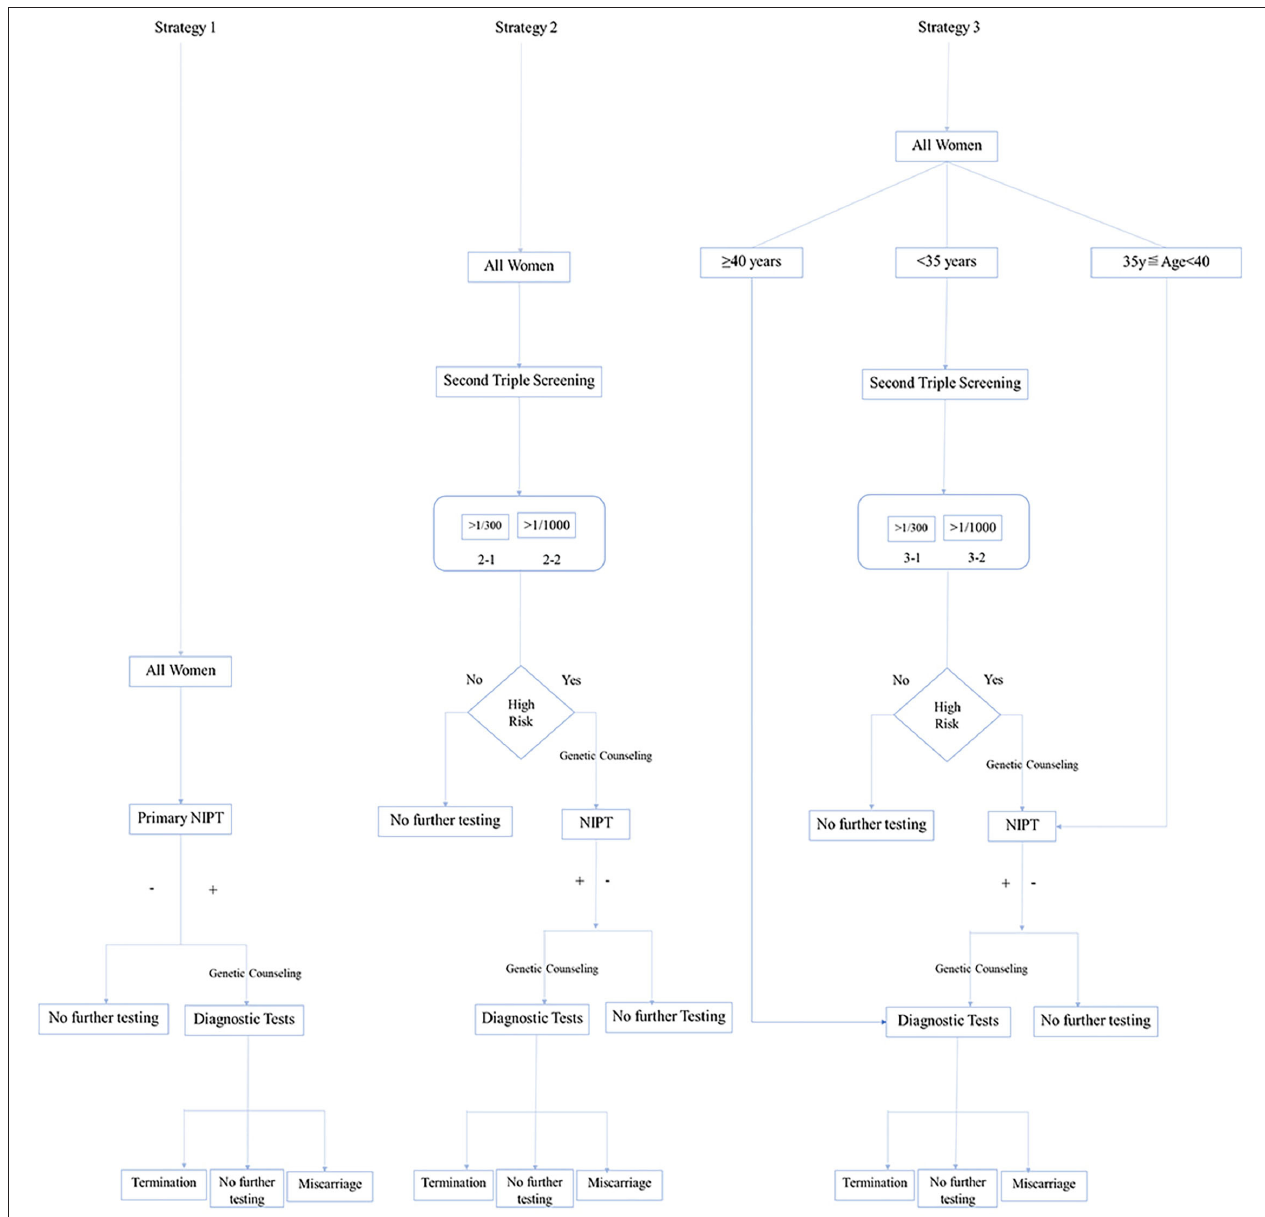
FIGURE 1 | Conceptional framework of three strategies for implementing non-invasive prenatal testing (NIPT).